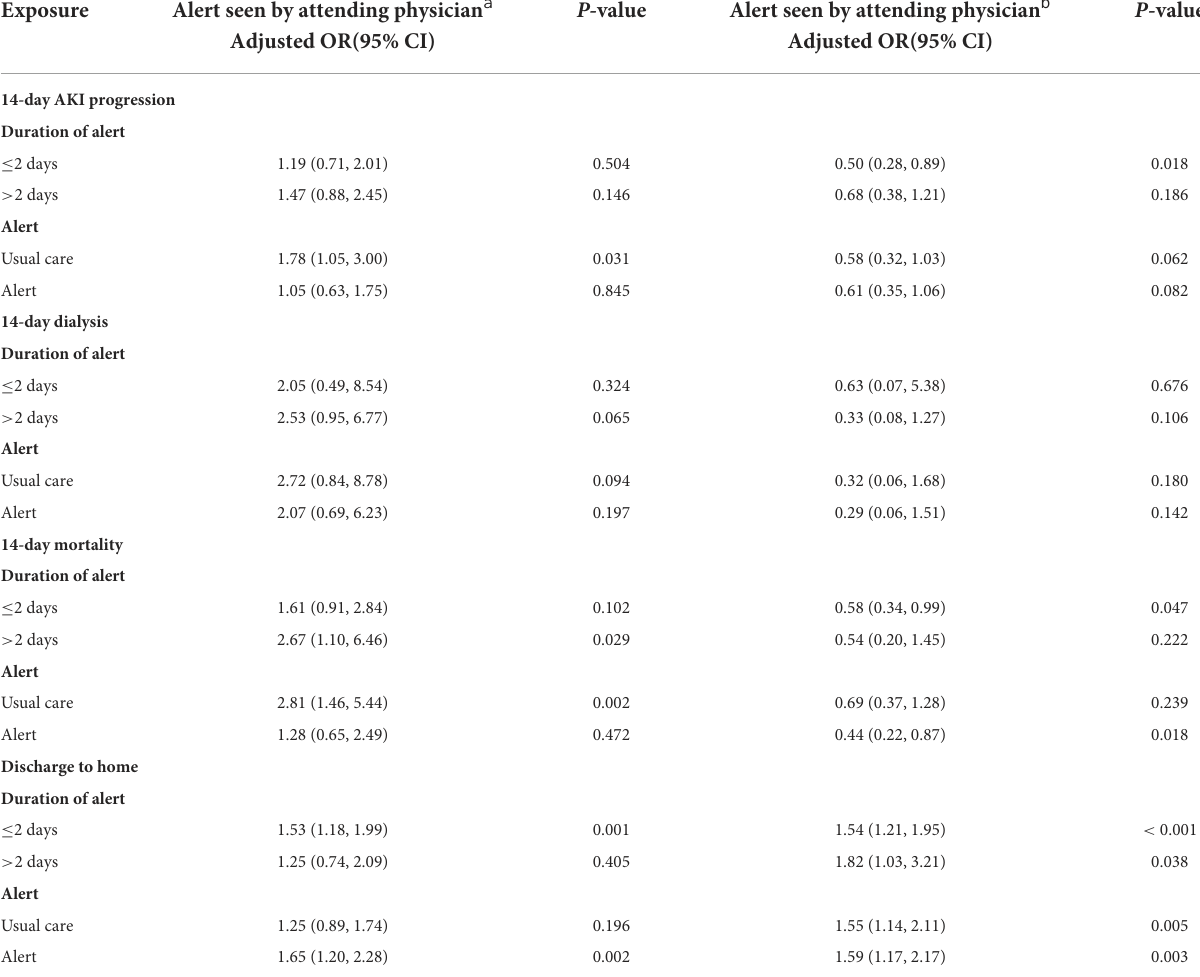
TABLE 3 Subgroup analysis of multivariate logistic regression